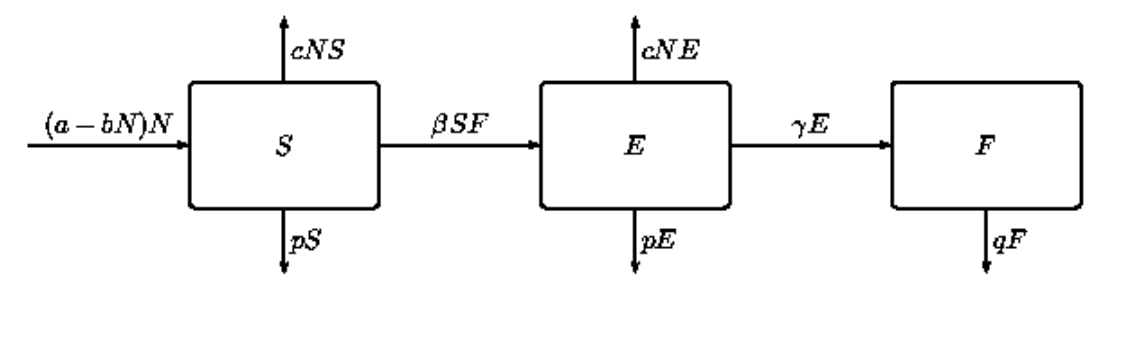
Fig. 1 Compartment diagram of the three-way (plant)-aphid-entomopathogen